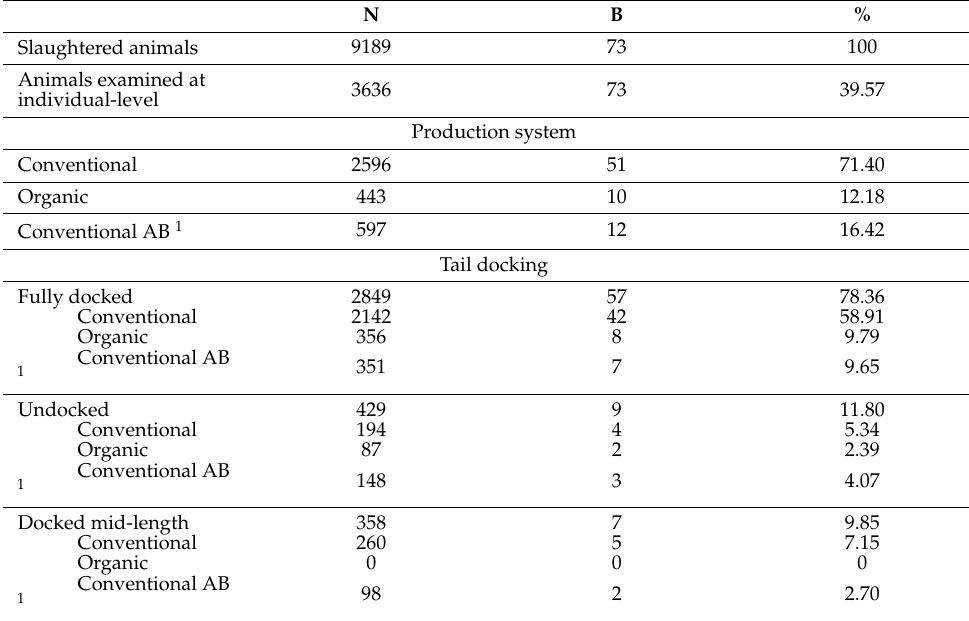
Table 1. Description of the total number of animals slaughtered ( n = 9189) with respect to the number of animals, batch size, production system and tail